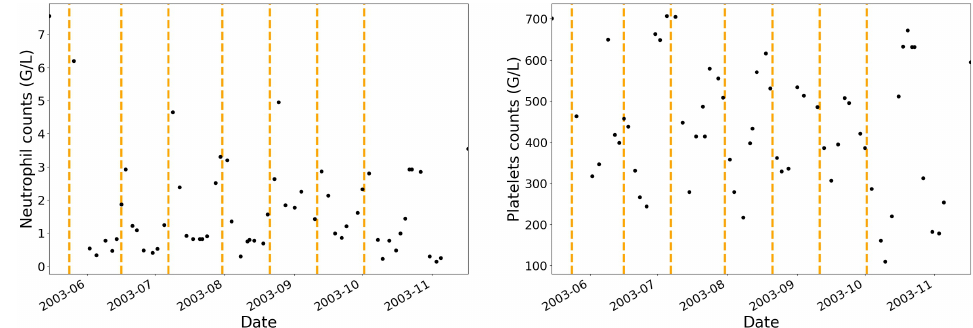
Figure 1. Example of one patient’s neutrophils and platelets data over the course of seven IVA treatment cycles. Black dots represent the observed data (neutrophils and platelets blood cell counts). Vertical dashed lines show the beginning dates of each treatment